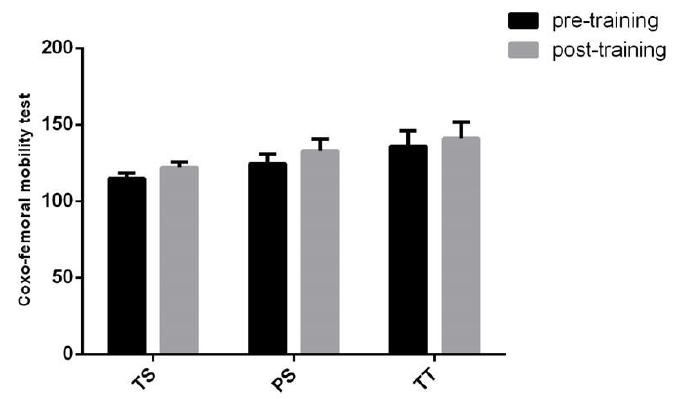
Figure 9. Coxo–femoral mobility test. The results are represented in bar graphs as the mean ± SD of the different phases considered (Turgor Secundus, Proceritas Secunda and Turgor Tertius).